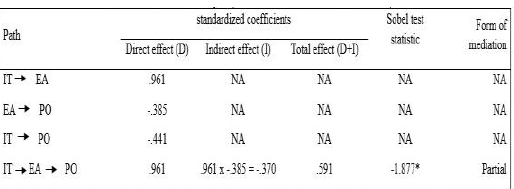
Table 7: Mediation Analysis (Direct and Indirect Effects